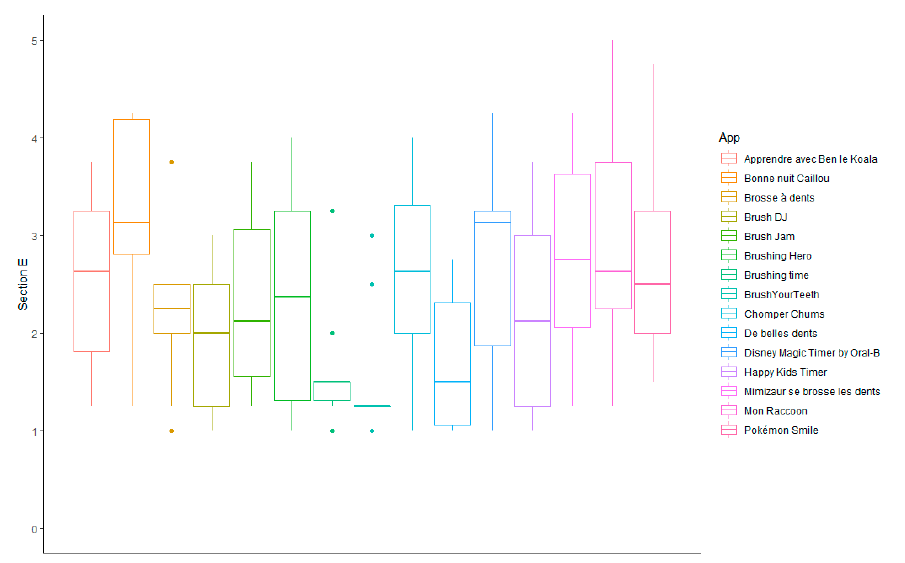
Figure 4. Subjective qualitative evaluation of oral hygiene-related mobile apps for children available in Sub-Saharan Africa (section E).